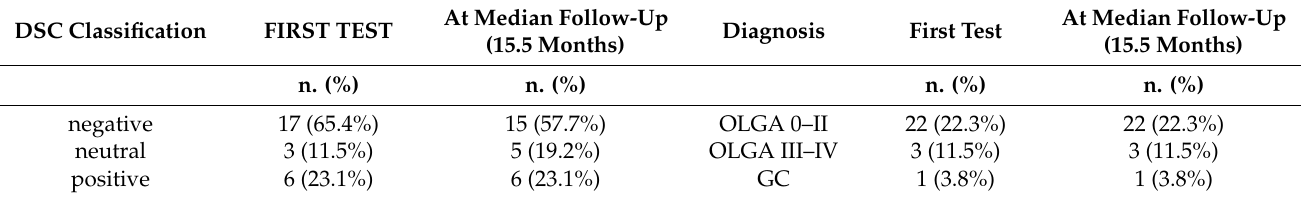
Table 5. Reproducibility of the DSC test.